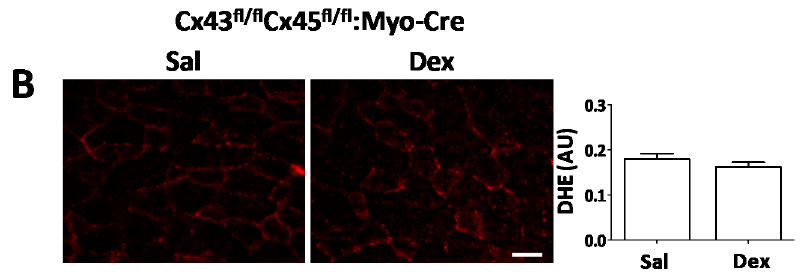
Figure 3. Vitamin E reduces the generation of reactive oxygen species induced by long term treatment with Dexamethasone. ( A ) Mice were treated daily during 7 days with saline (Sal) or dexamethasone (Dex; 10 mg / kg / day) or Dex and fed with Vitamin E (VitE) supplemented diet (Dex + VitE). Then, the oxidation of dihydroxy ethidium (DHE) was visualized in cross sections of TA muscles (red). The graph shows the red fluorescence intensity measured using Image J software. The results are expressed as mean ± SEM. (Saline; n = 5; Dex; n = 5; Dex + VitE; n = 3). ( B ) DHE staining in TA muscles from Cx43 / Cx45 expression-deficient (Cx43 fl / fl Cx45 fl / fl :Myo-Cre) skeletal myofibers mice treated with Dex. The graph shows the red fluorescence intensity measured using Image J software. The results are expressed as mean ± SEM. (Sal; n = 5; Dex; n = 5). ** p < 0.01; *** p < 0.001; as indicated with brackets. Scale bar: 50 μ m.